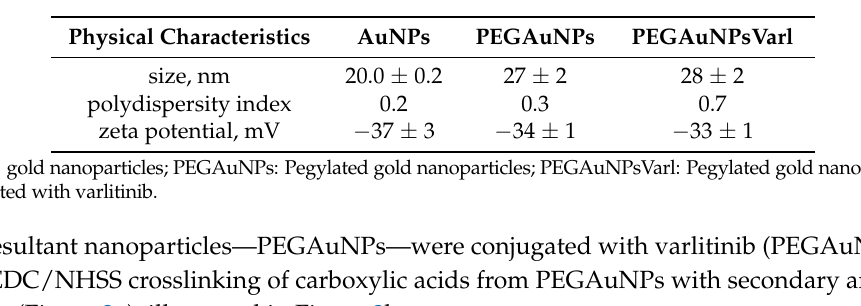
Table 1. Physical characteristics of AuNPs, PEGAuNPs, and PEGAuNPsVarl.